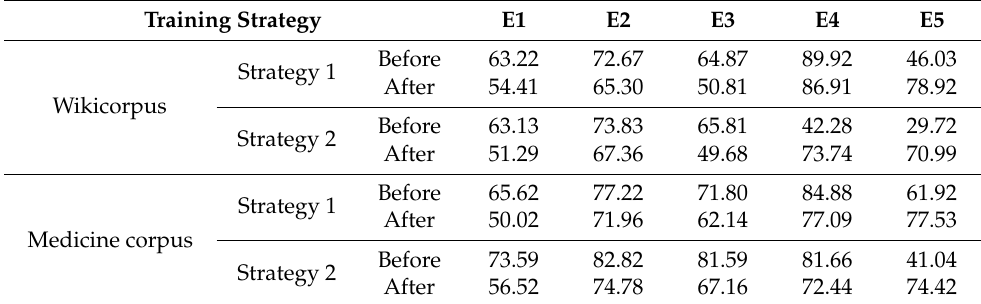
Table 15. Comparison of F 0.5 measures before and after removing the subject-verb concordance error type and selecting Hunspell-generated errors of Levenshtein distance equal to two. No pretrained embedding was used. (E1) genre, (E2) number, (E3) genre-number, (E4) homophones and (E5) Hunspell-generated